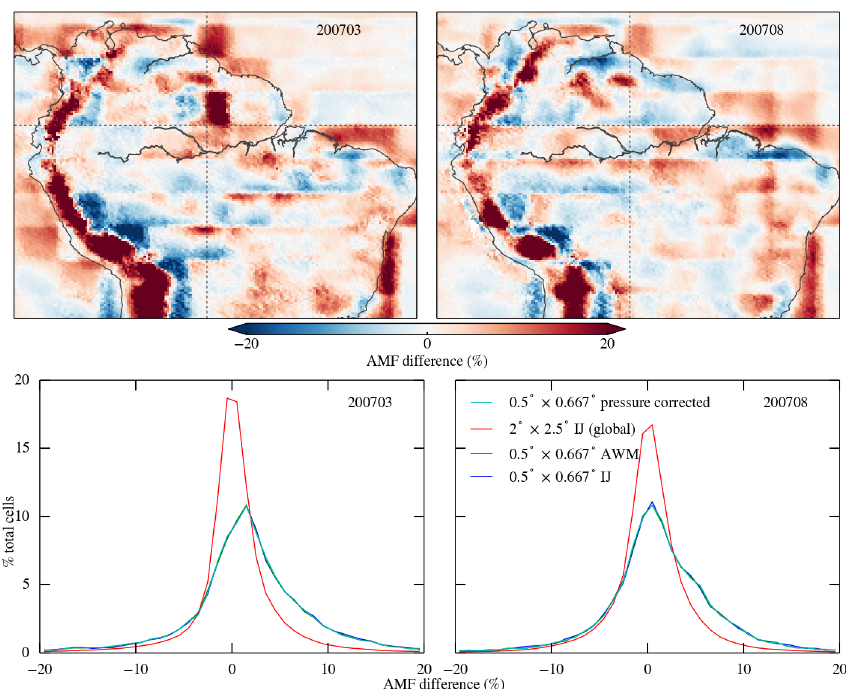
Figure 4. Top row: spatial maps of monthly mean AMF differences for March and August 2007, relative to the default UoL AMF algorithm, resulting from the use of atmospheric profiles from the GEOS-Chem 0.5 ◦ × 0.67 ◦ nested grid simulation, as outlined in Sect. 5.2. The AMFs are gridded on to a 0.25 ◦ × 0.25 ◦ grid using observations with cloud fractions < 40%. Bottom row: the corresponding histograms of the AMF differences for these two months are shown in blue. The histogram of global AMF differences arising from the use of atmospheric profiles from GEOS-Chem’s 2 ◦ × 2.5 ◦ simulation is shown in red. Also shown are histograms resulting from the area-weighting (green) and surface pressure correction (aqua) of the 0.5 ◦ × 0.67 ◦ nested grid profiles, as discussed in Sects. 5.3 and 5.4 respectively. Note the closeness of lines detailing derivatives of the high-resolution 0.5 ◦ × 0.67 ◦